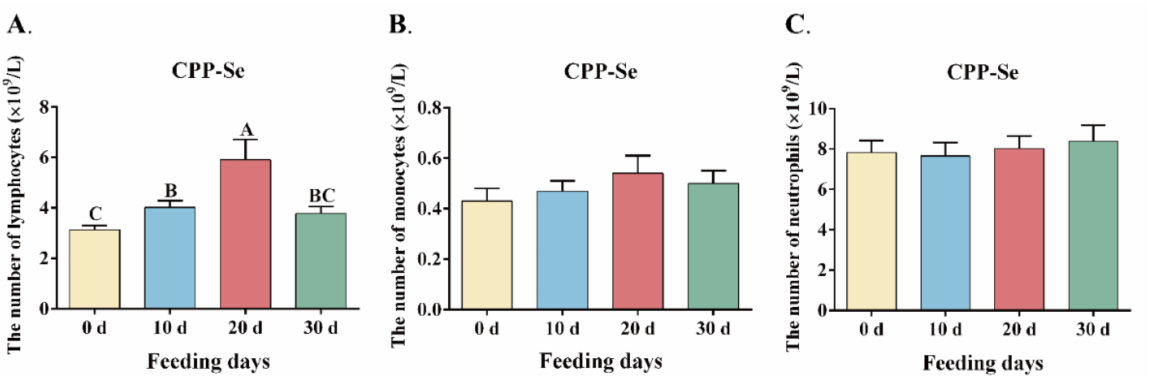
Figure 2. Changes in the number of lymphocytes ( A ), monocytes ( B ) and neutrophils ( C ) during the feeding period. Values are means with standard error bars, means with different letters are different ( p <